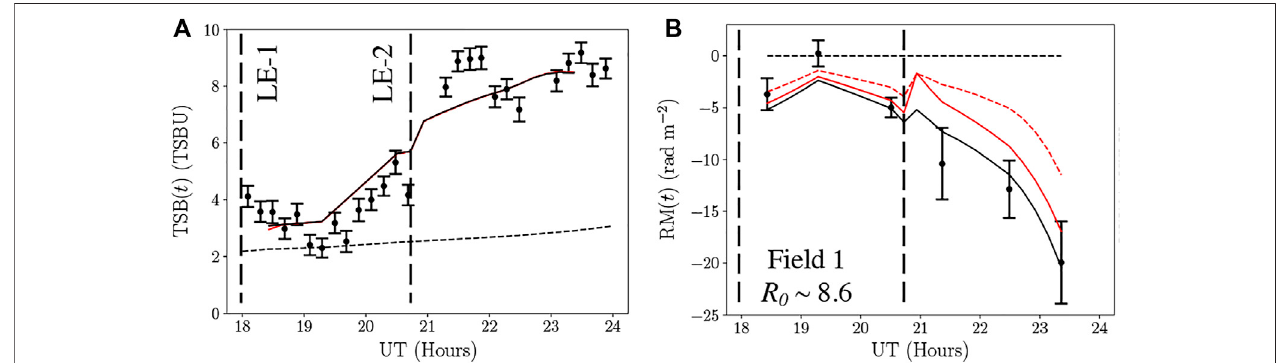
FIGURE 10 | Thomson-scattering brightness (TSB, (A) ) and Faraday rotation measure (RM, (B) ) through a CME using a radio galaxy as the background radio source, asreportedinKooietal.(2021).ThesedatacorrespondtooneofthethirteenLOSused toprobethisCME.The2015July31eventwasmodeledassuming one CME:LE-1 corresponds tothe leadingedge oftheCME ’ snorthern (in heliographic latitude)leg and LE-2corresponds tothe leadingedge ofthesouthern leg.Theblack dashed line corresponds to the coronal contribution. The black solid, red solid, and red dashed lines correspond to the constant density, thin shell, and thick shell CME n e models. These data correspond to values reported for 2015 July 31 h in Table 3 . This appears as Figure 9 in Kooi et al. (2021), ©Springer, reproduced with